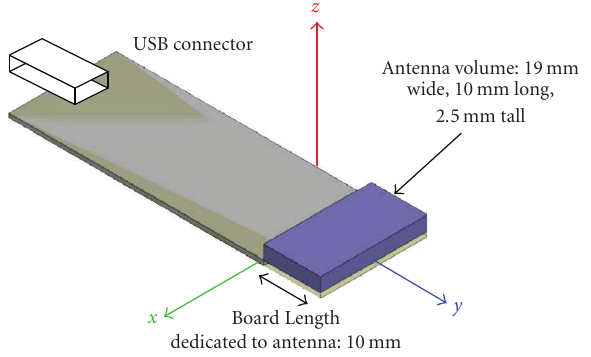
Figure 3: Example of WiMAX USB antenna illustrating small antenna volume of 19mm wide by 10mm high and extending away from PCB distal end by 10 mm,